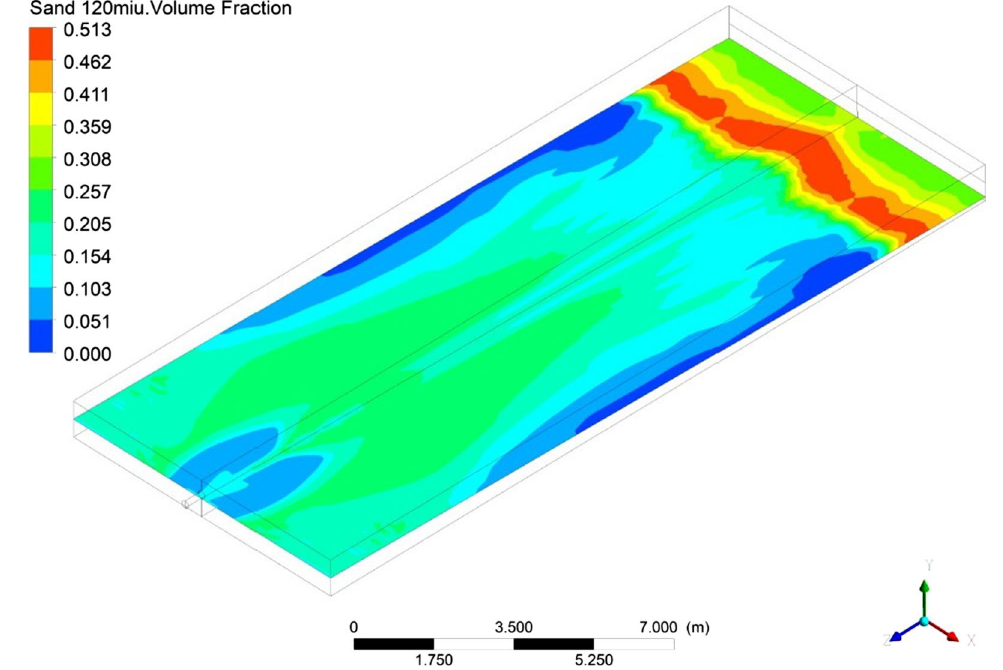
Fig. 14 Volume percentage of 120 μm sediment at 386.415 s